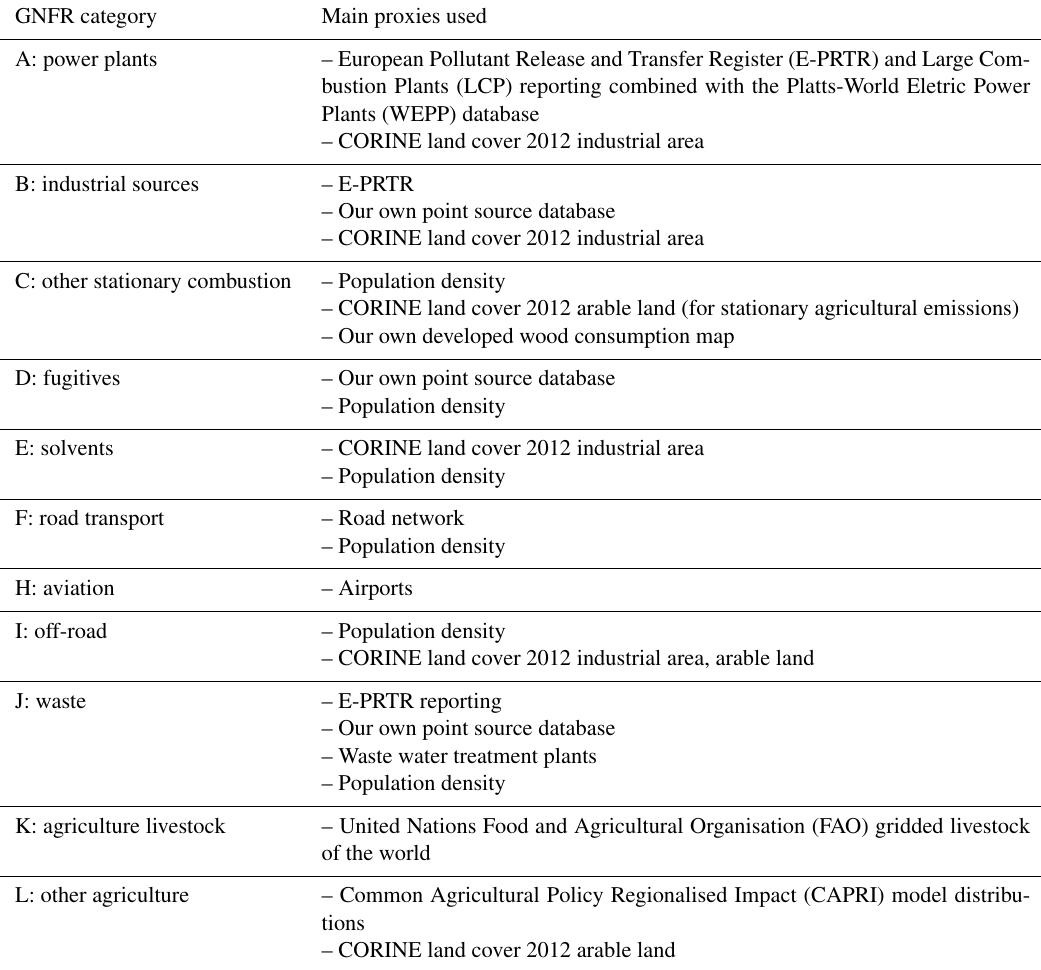
Table 1. Summary table with main proxies per GNFR source category. GNFR